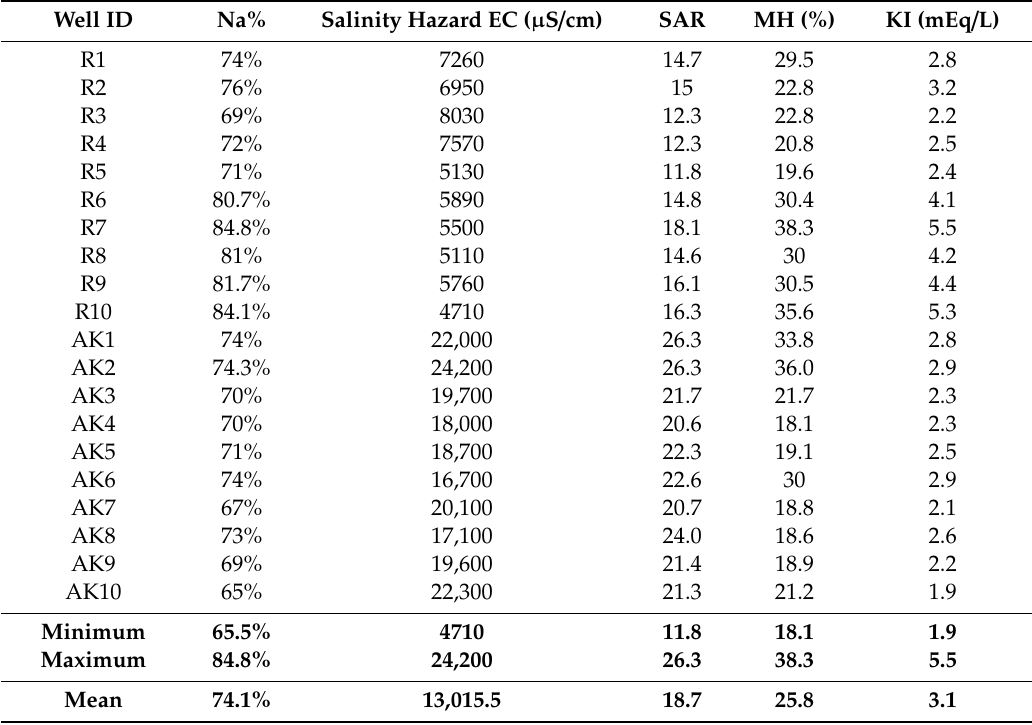
Table 3. Groundwater classification for irrigation use (R: Remah; AK: Al